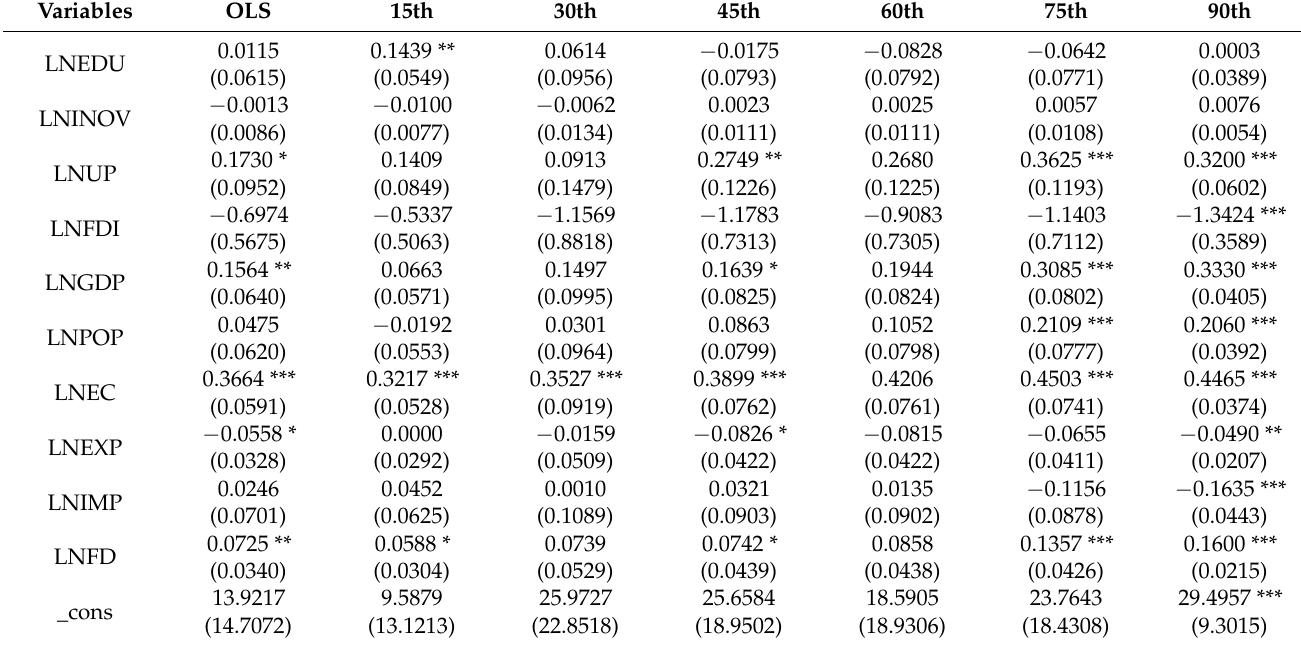
Table 4. Quantile Regression Results (Lower-Middle Income